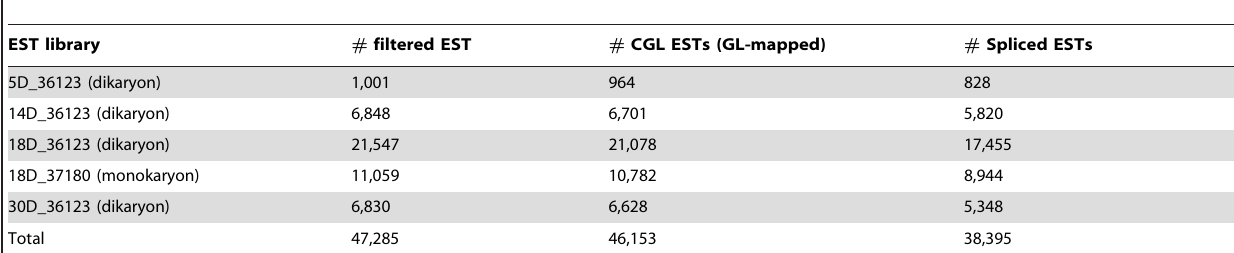
Table 1. The number of ESTs obtained from the various mycelia that had been cultured for a different number of days.